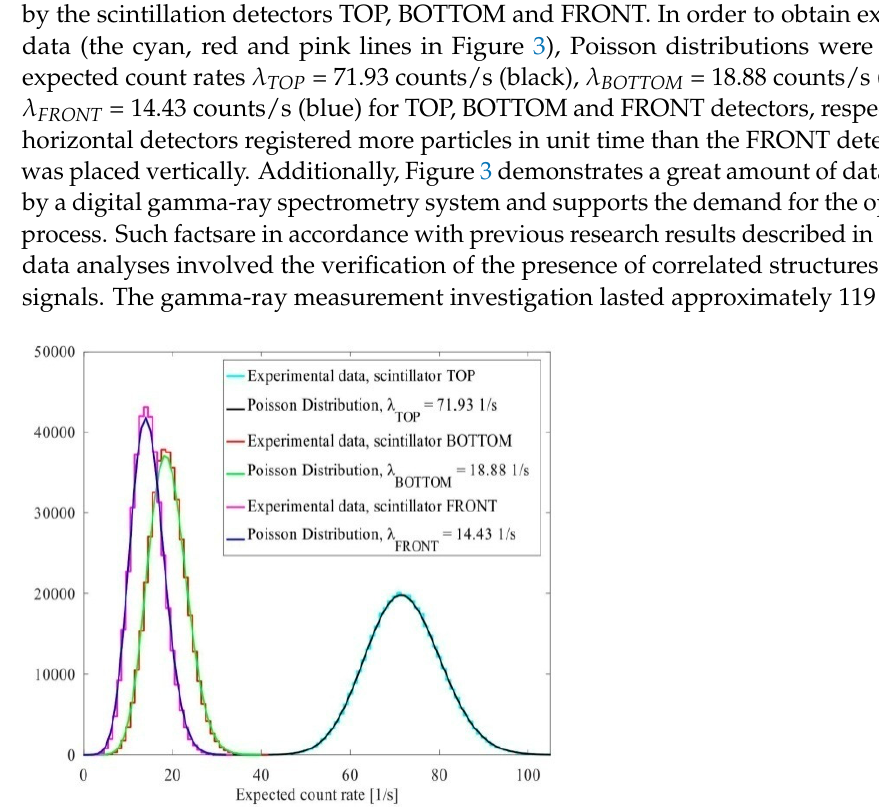
Figure 3. Expected count rate distributions for scintillation detectors: TOP (71.93 counts/s), BOTTOM (18.88 counts/s) and FRONT (14.43 counts/s).